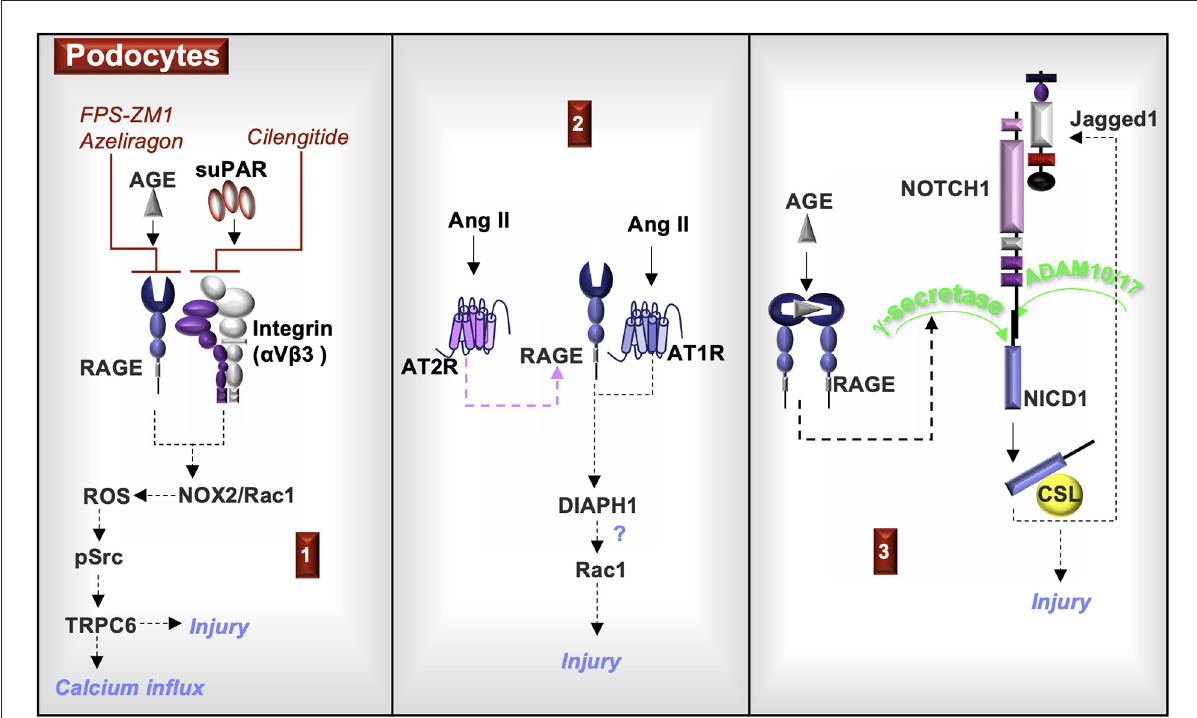
FIGURE3 RAGE signaling in podocytes . (1) Exposure of podocytes to either AGE or soluble urokinase plasminogen activator receptor (suPAR) activates the NADPH oxidase 2 (NOX2) and Rac1, which is a component of the NOX2 multiprotein complex. NOX2 generates reactive oxygen species (ROS) that activates Src kinases and induces the production of the calcium channel, TRPC6. Each of these responses can be inhibited by either RAGE antagonists (FPS-ZM1or azeliragon) or by an α V β 3 integrin antagonist (cilengitide, an angiogenesis inhibitor). Changes in TRPC6 activity are associated with podocyte injury. (2) Angiotensin II (Ang II) activation of the Ang II type 2 receptor (AT2R) induces RAGE expression. Ang II also activates AT1R, which transactivates RAGE and induces the common RAGE downstream signal, diaphanous homolog 1 (DIAPH1). In additional cell types, DIAPH1 induces Rac1 activity, suggesting a potential similar function in podocytes. Rac1 activity can damage podocytes and induce foot process effacement. (3) AGE activation of RAGE induces the production of γ -secretase, which cleaves NOTCH1 to form the transcription co-activator, NOTCH1 intracellular domain (NICD1). NICD1 complexed to CBF-1/suppressor of hairless/LAG-1 (CSL) promotes the transcription of the NOTCH ligand, Jagged1. NOTCH1 cell signals in podocytes are associated with